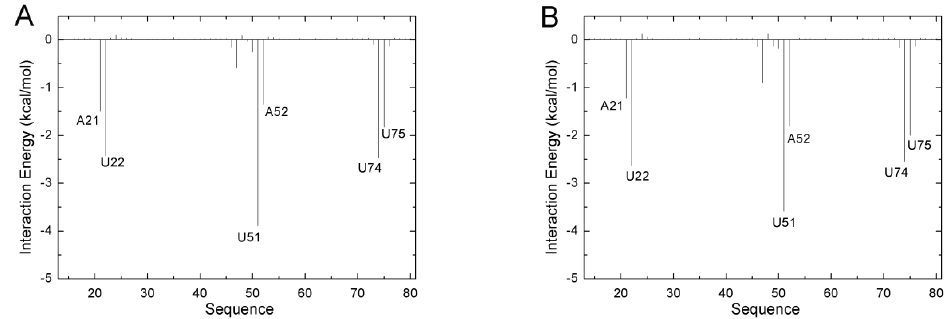
Figure 2. The decomposition of inhibitors on a per-nucleotide basis for the ADE and GR(C74U) complex ( A ), as well as for the ADE and AR complex ( B ).